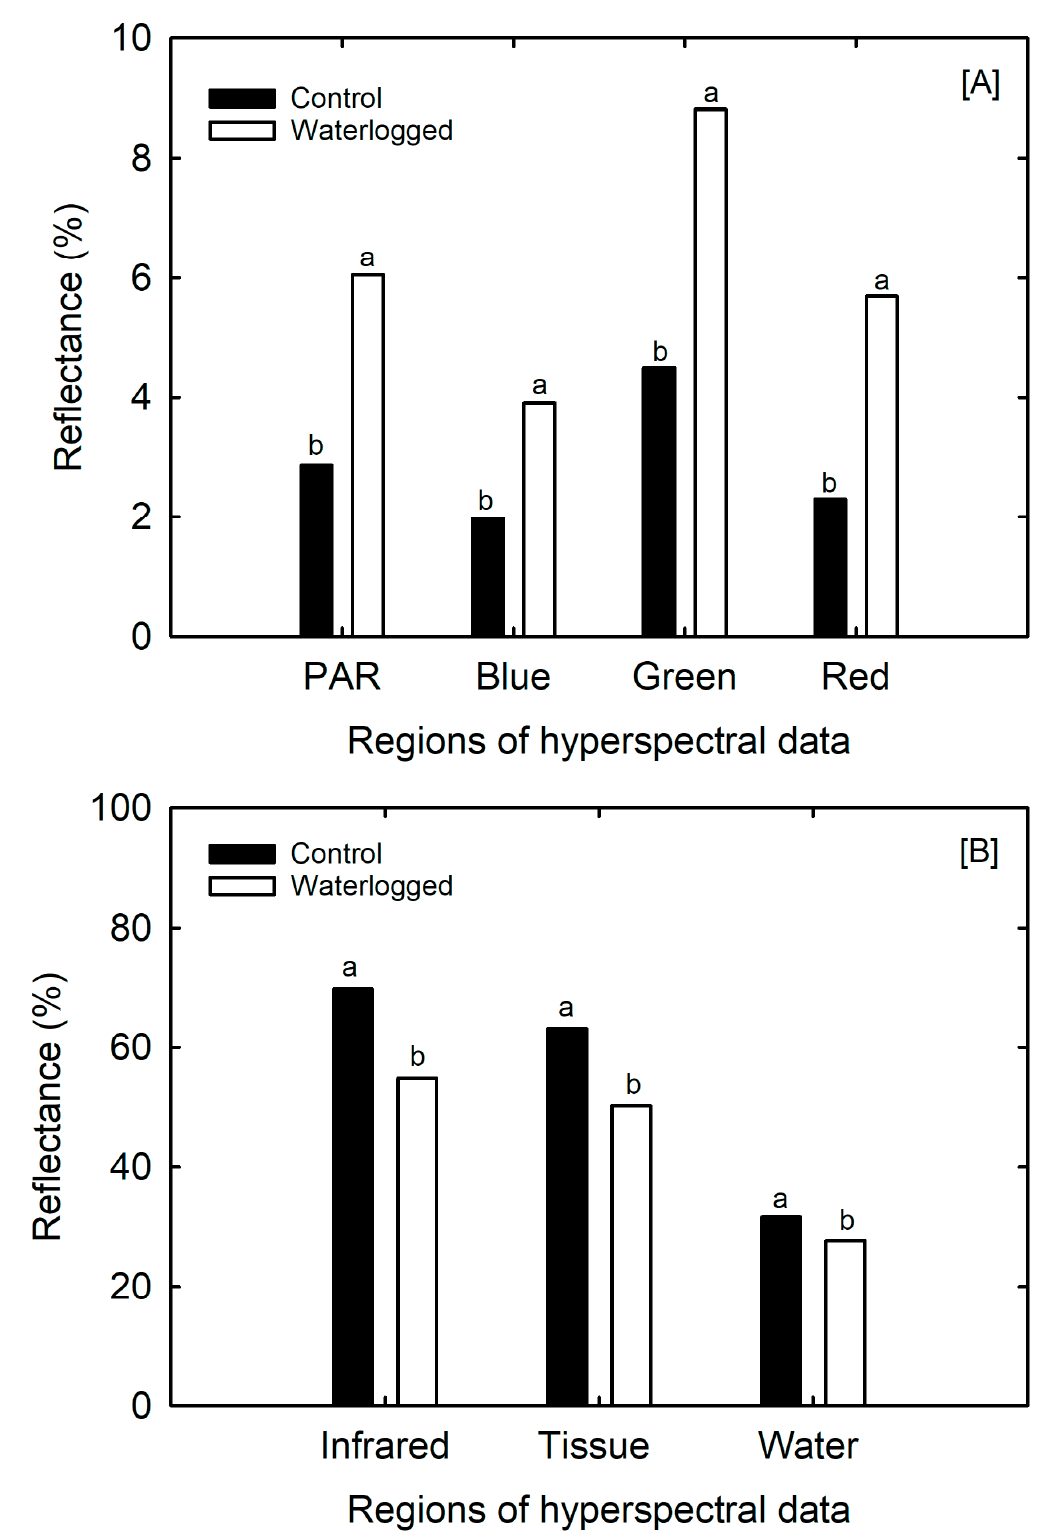
Figure 6. Effect of waterlogging on regions of the hyperspectral curve of soybean leaf, Figure 6. E ff ect of waterlogging on regions of the hyperspectral curve of soybean leaf, (A) PAR = ( A ) PAR = 400–700 nm, blue = 400–520 nm, green = 520–600 nm, and red = 630–690 nm) and ( B 400–700 nm, blue = 400–520 nm, green = 520–600 nm, and red = 630–690 nm) and (B), infrared = 760– 900 nm, tissue = 900–1350 nm, and water = 1600–1850 nm, associated with leaf physiological charac- ters. Data are mean ± S.E. (n = 15).